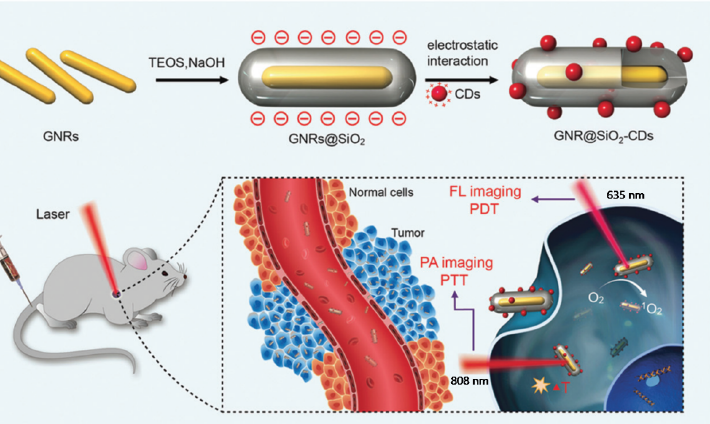
Figure 9. Schematic illustration of GNR@SiO 2 -CDs as a phototheragnostic agent for dual-modality FL and PA imaging-guided synergistic PDT/PTT therapy. Reprinted with permission from [91]. Copyright, The Royal Society of Chemistry (2016).